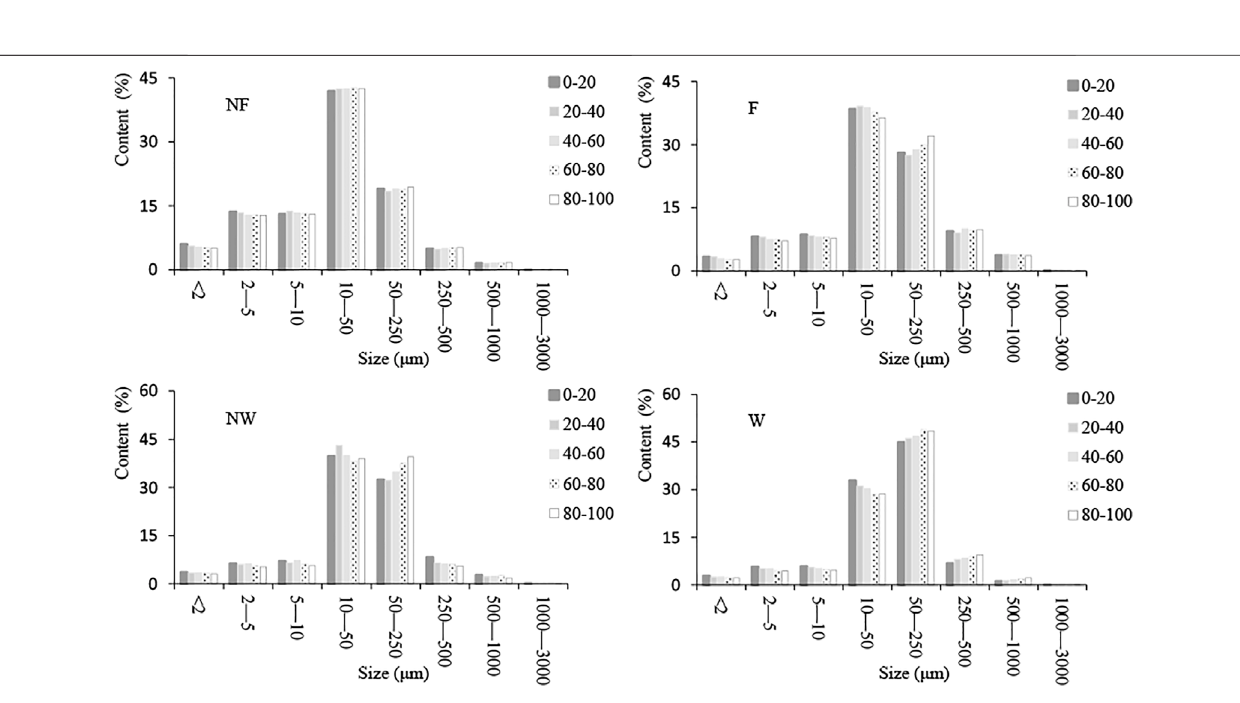
Frontiers in Environmental Science |